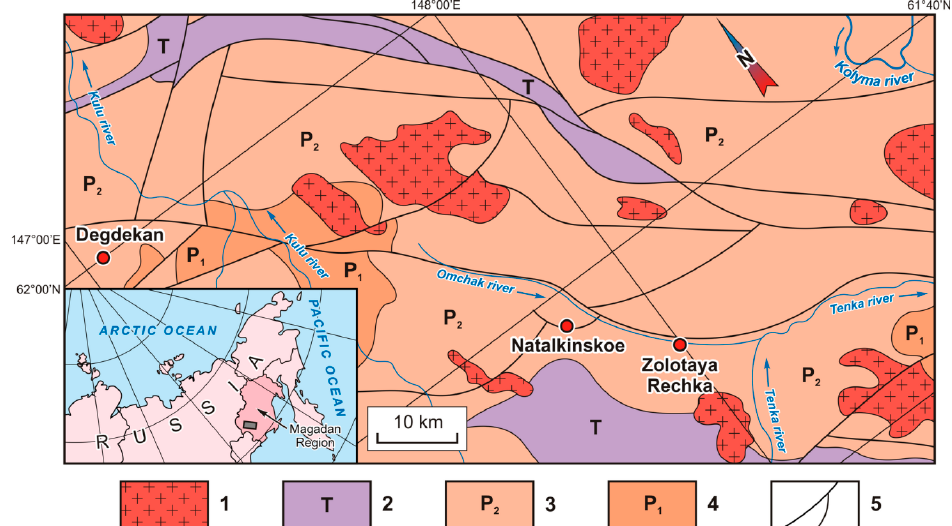
Figure 1. The Natalkinskoe, Degdekan and Zolotaya Rechka deposits on a simplified scheme of geologic aspects of the area of investigations. Compiled by the authors of the present paper using the data by Goncharov et al. [40]. The inset map shows the location of the deposits within the territory of the Magadan region. 1—granitoid massifs; 2—Triassic siltstones and mudstones; 3—upper Permian aleuropeliticshaleswithfragmentsofdi ff erentcompositionrocks, aleuropeliticandcarbono-argillaceous shales, carbonaceous siltstones, siltstones, sandstones, tu ff sandstones and gravelites; 4—lower Permian mudstones, siltstones and sandstones; 5—faults.